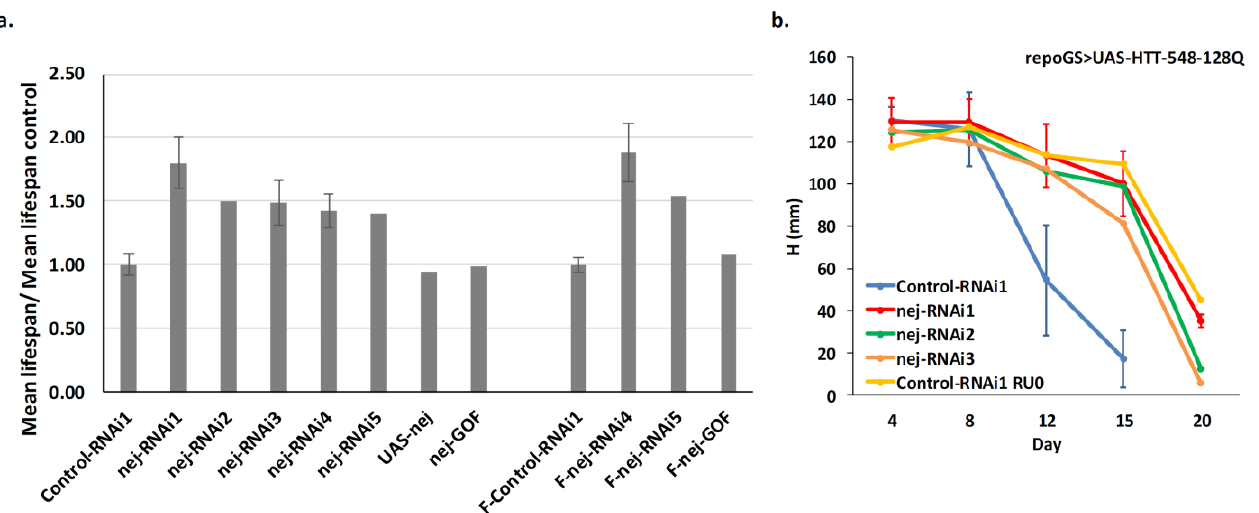
Figure 6. Extended longevity and improved locomotor activity of HD flies depleted for dCBP in glia. ( a ) Several independent RNAi transgenes targeting dCBP and transgenes leading to dCBP overexpression (see Table S4 for detailed genotypes) were assayed for their ability to modulate the lifespan of repoGS > UAS-HTT-548-128Q flies. All the RNAi lines tested increased the fly lifespan while the overexpressing lines have no effect, irrespective of the sex of the tested animals (F-: female flies, otherwise males). Error bars: standard deviation, provided when several independent experiments were performed. ( b ) The same flies were submitted to a negative geotaxis assay and their performance evaluated as the mean height at T = 7s. All the flies performed similarly until day 8 but, from day 12, the repoGS > UAS-HTT-548-128Q flies show a strong deficit of performance compared to control flies ( p value < 0.0002, two sided t -test) which is almost abolished when dCBP is depleted. At 12 days, all the scores of the RNAi lines were not significantly different from the control line ( p > 0.1, two sided t -test). At 15 days, only the score of the RNAi1 line was not significantly different from the control line ( p < 0.05, two sided t -test) while the score of the RNAi2 and RNA3 lines were significantly different from the control line ( p < 0.005, two sided t -test), reflecting incomplete rescue. Error bars: SE for N independent experiments (N = 2, 2, 5, 6, 4 at day 4, 8, 12, 15, 20, respectively).